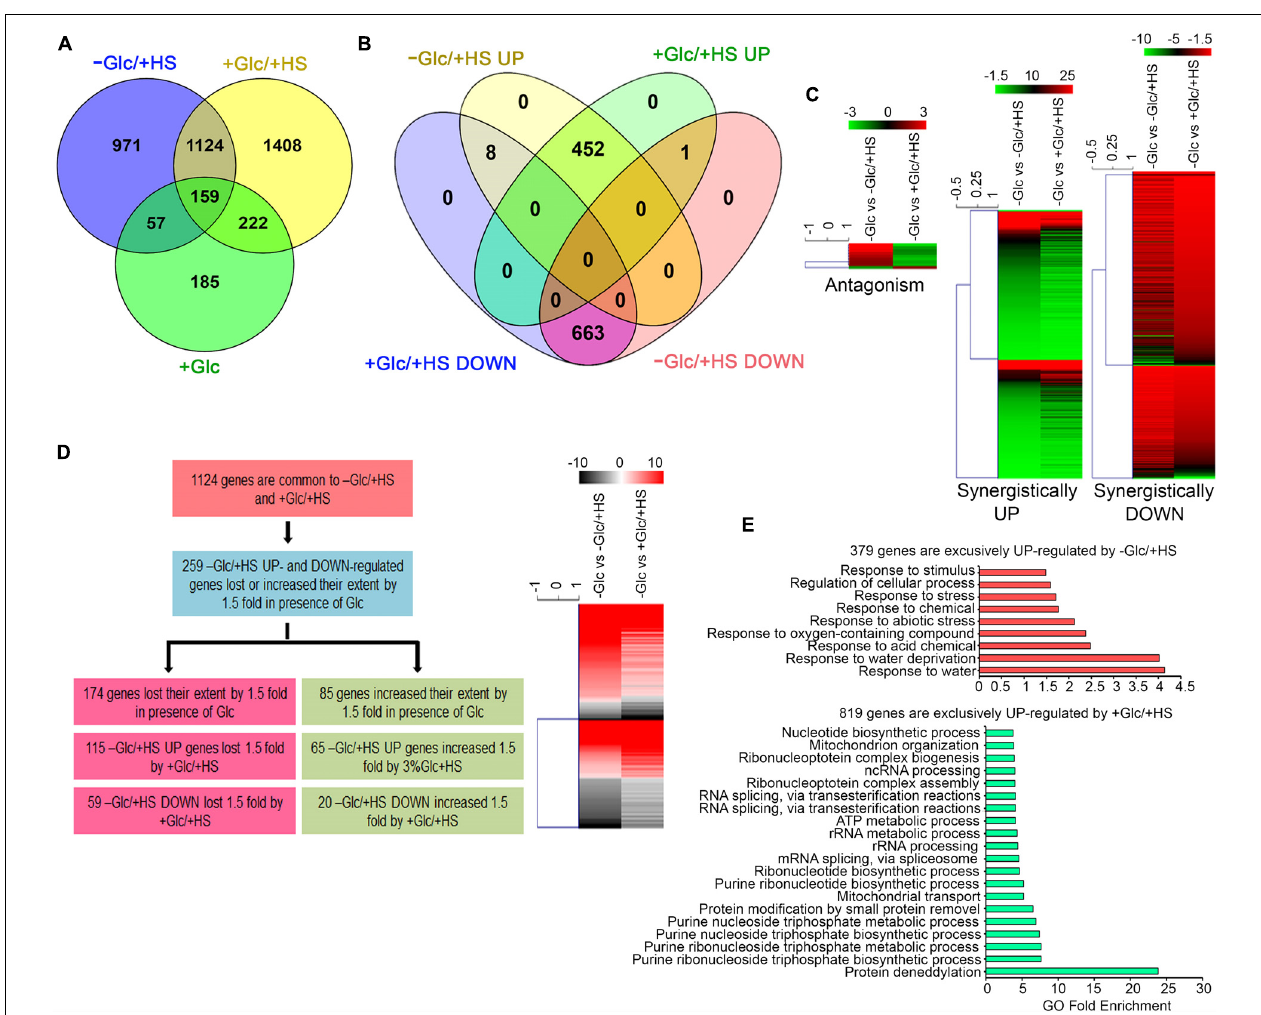
FIGURE 2 | Glc triggers transcriptome reprogramming of HS-regulated genes. (A) A Venn diagram showing overlap of genes induced by –Glc/ + HS, + Glc/ + HS, and + Glc only. (B,C) A Venn diagram and heat maps showing synergistic and antagonistic relation of genes induced by –Glc/ + HS and + Glc/ + HS. (D) A picture showing the difference in gene expression extent in common genes affected both by –Glc/ + HS and + Glc/ + HS. Genes induced by –Glc/ + HS affected (loss/increase in extent) by 1.5-fold in the presence of Glc were taken into consideration. (E) Gene ontology enrichment of genes exclusively induced by –Glc/ + HS and + Glc/ + HS, respectively. The top 20 GO categories were plotted. Data shown are an average of three biological replicates. Venn diagrams were created using Venny v2.1; heat maps were created using Mev. Panther 15.0 tool was used to analyse GO-fold enrichment using Bonferroni correction and Fisher’s exact test type.